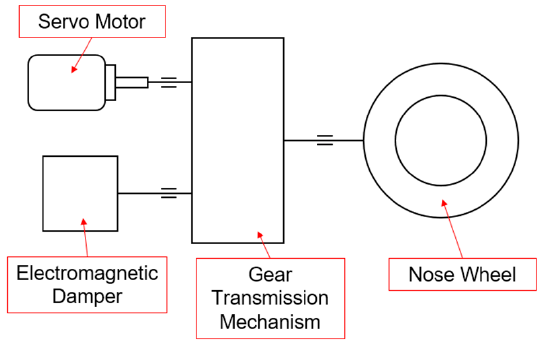
Figure 4. The design of transmission mechanism.